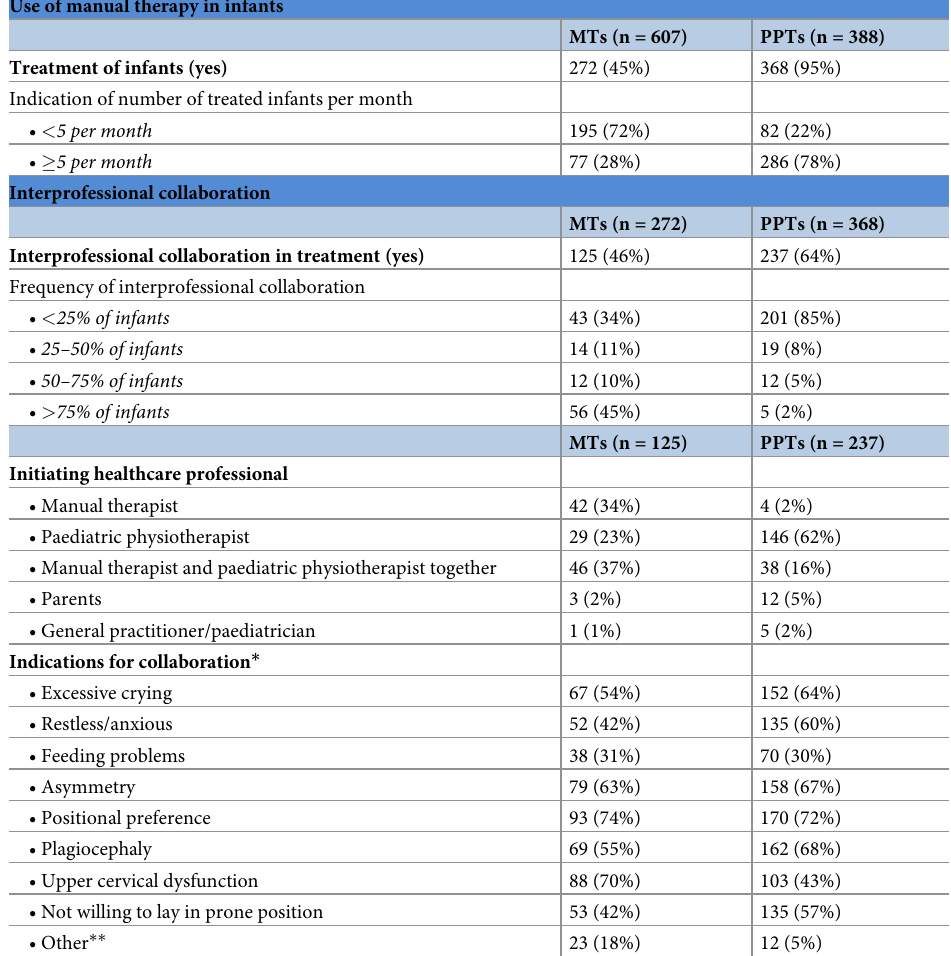
MTs (n = 607) PPTs (n = 388) MTs (n = 272) PPTs (n = 368)